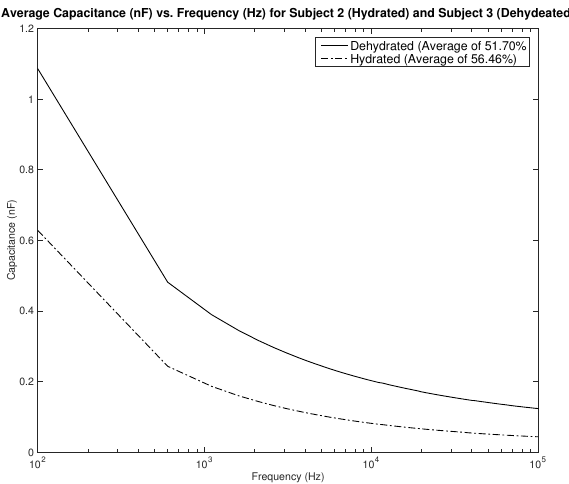
Figure 17. Testing results—capacitance (nF) vs. frequency (Hz): comparison of measurements taken on the right (solid line) and left (dashed line) arm.